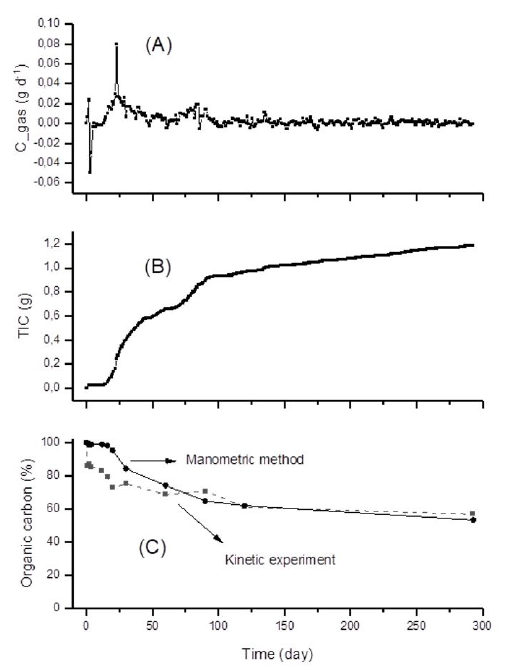
Figure 2. (A) Temporal variations of C_gas daily rate (C_gasDR; g d -1 ) during mineralization of Typha domingensis under controlled conditions (dark and 23.3 ± 1.8 ºC); Cunha-Santino et al. (2016). (B) Kinetic of C_gas during the mineralization of Typha domingensis under controlled conditions (dark and 23.3 ± 1.8 ºC); Cunha-Santino et al. (2016). (C) Remaining organic material (POC+DOC) from the decomposition of Typha domingensis established from the manometric method and recorded by the kinetic experiment (Cunha-Santino & Bianchini Júnior,